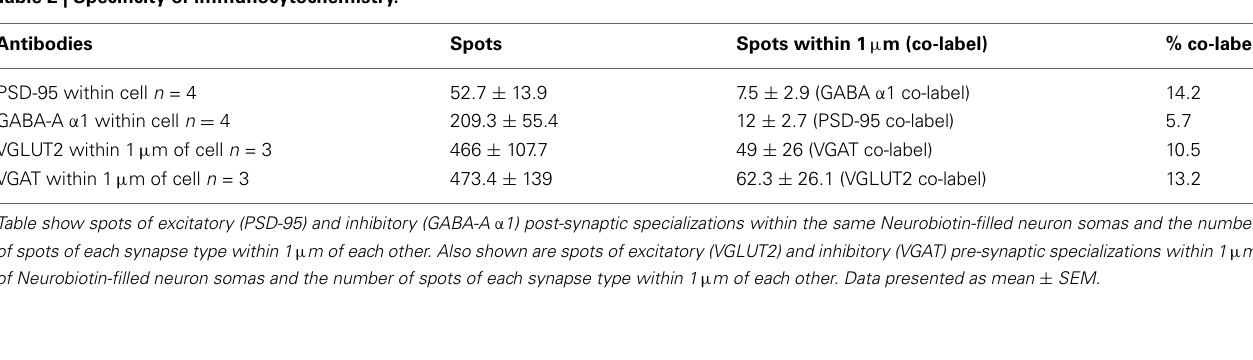
Table 2 | Specificity of immunocytochemistry.